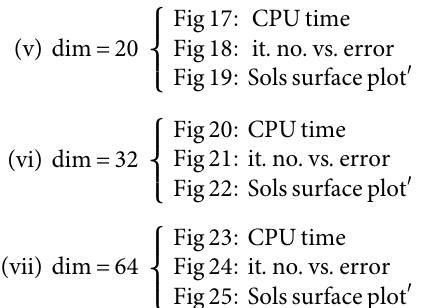
(viii) Figure 26 represents the average CPU time through bar graphs for different dimensions